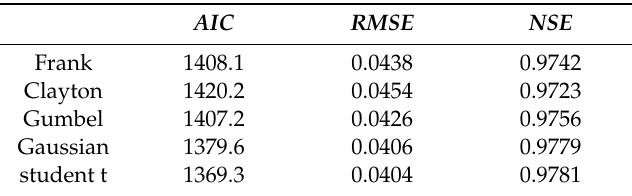
Table 4. Fitting evaluation of copulas for the Rasht